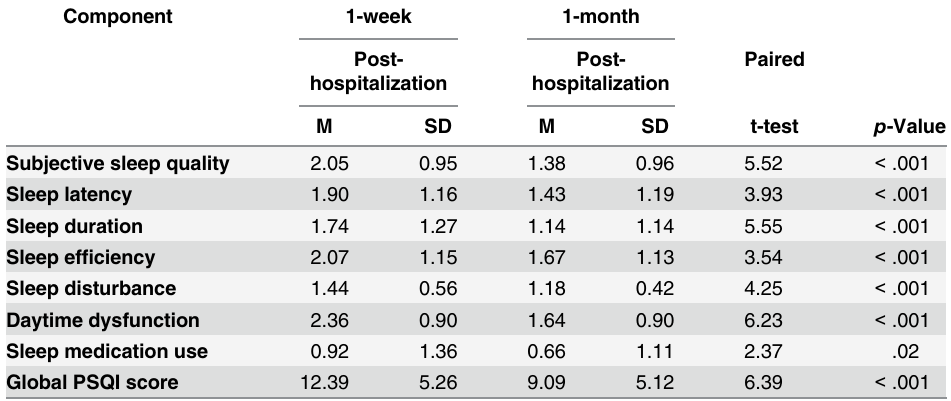
Table 2. PSQI scores: 1 week and 1 month post-hospitalization; comparison with paired t-test ( n =